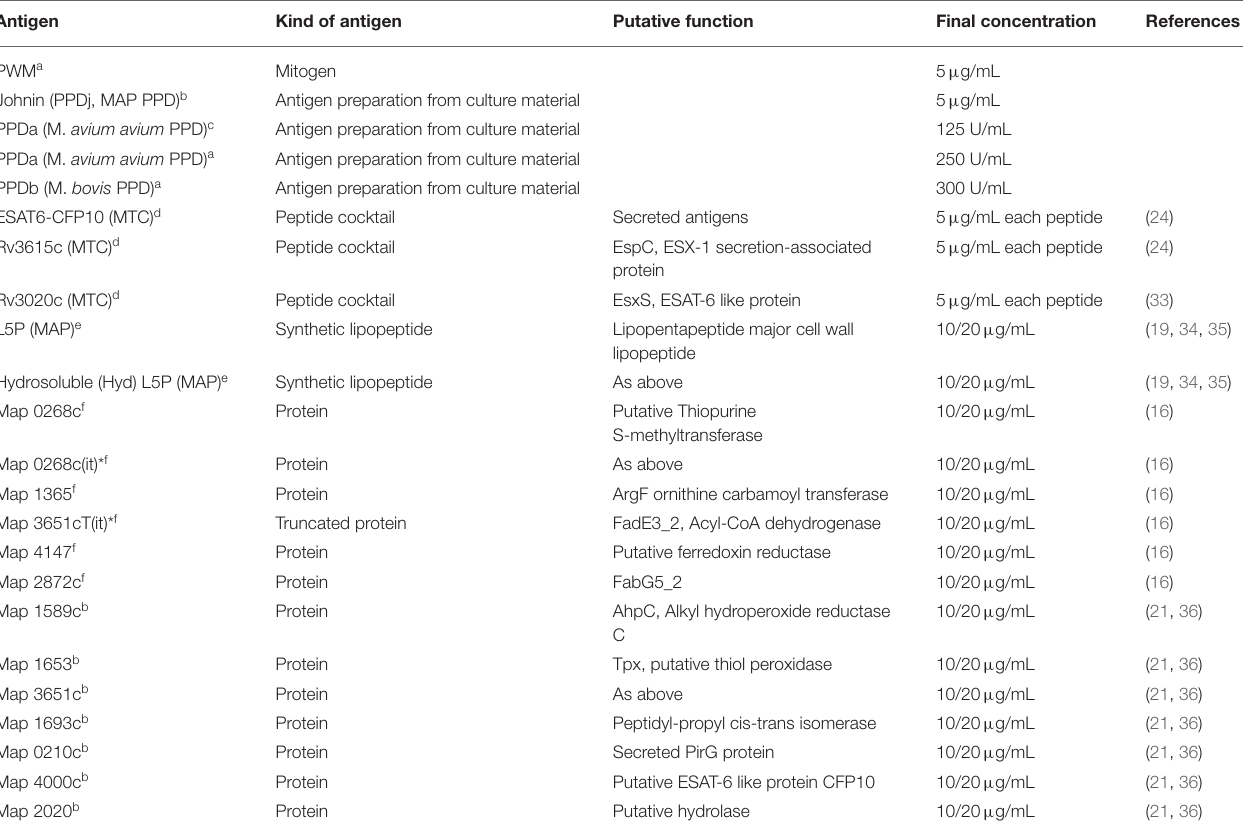
TABLE 1 | IGRA: Designation and kind of antigens used for whole blood stimulation, final concentrations applied and their source including reference. Antigen Kind of antigen Putative function Final